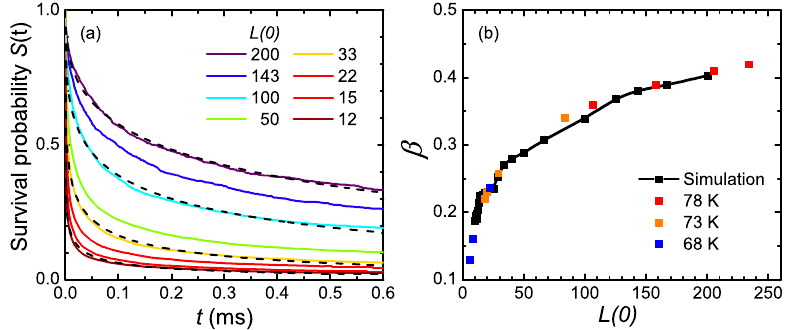
Figure 31. ( a ) Survival probability S ( t ) of a domain wall pair on a one-dimensional chain as a function of time for different average domain sizes L ( 0 ) . The signal can be very well modeled by a Kohlrausch–Williams–Watt function (dotted line); ( b ) Fit parameter β as a function of L ( 0 ) derived from the fit of the KWW function to the simulated (black lines and dots) and the experimental S ( t ) curve (colored squares) (After